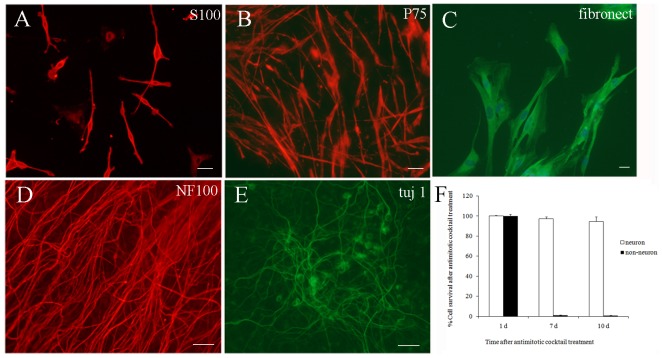
The survival of DRG neurons and non-neuronal cells after cocktail treatment.(A–F) The immunocytochemistry for DRG neurons and non-neuron cells (on day 4). A–C: non-neuron cells (include all the S100+, P75 NRT+ and fibronect+ cells); Scale bar 10 µm; D–E: DRG neurons (include the NF-100+ and tuj 1+ cells); Scale bar 50 µm. F. The survival of DRG neurons and non-neuronal cells after cocktail treatment. Cell survival assessed as mean cells counts per well after 1, 7, 10 days culture. Data are means ± SEM. (n = 3). (Dunnett's test; P>0.05).